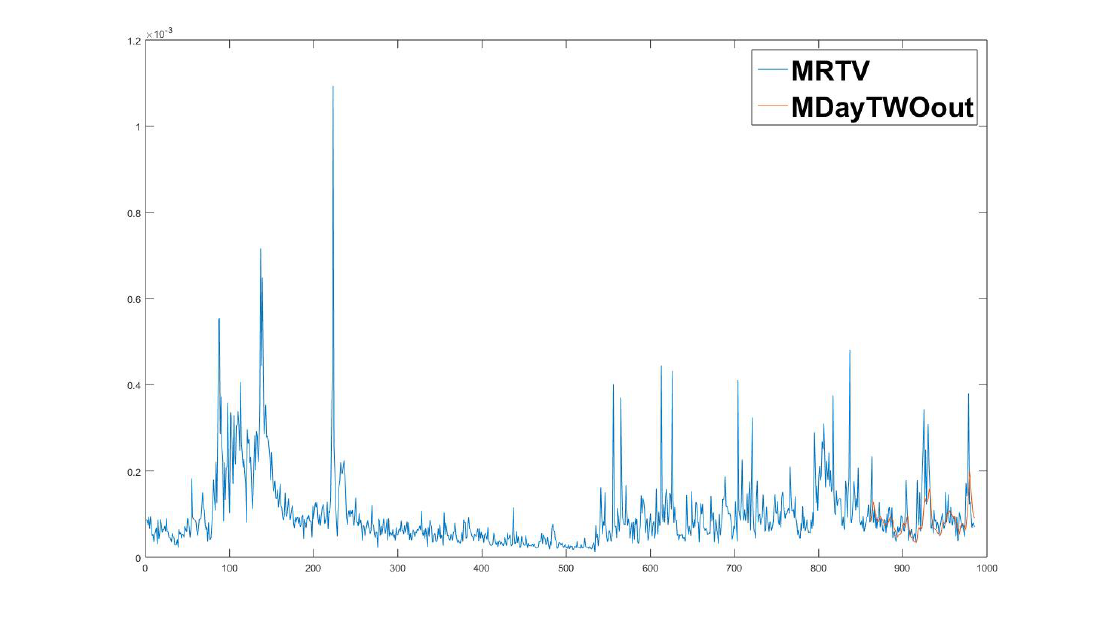
Figure 5. Model TWO-RTV-D Forecast for M(DCE). The horizontal line is the timeline, and the perpendicular line is the volatility estimator. The forecasted period is the last 124 days. The actual values are represented by the blue line, while the forecasted values are represented by the orange line. The forecasted values are closed to the actual values, except for a sharp jump around the Day